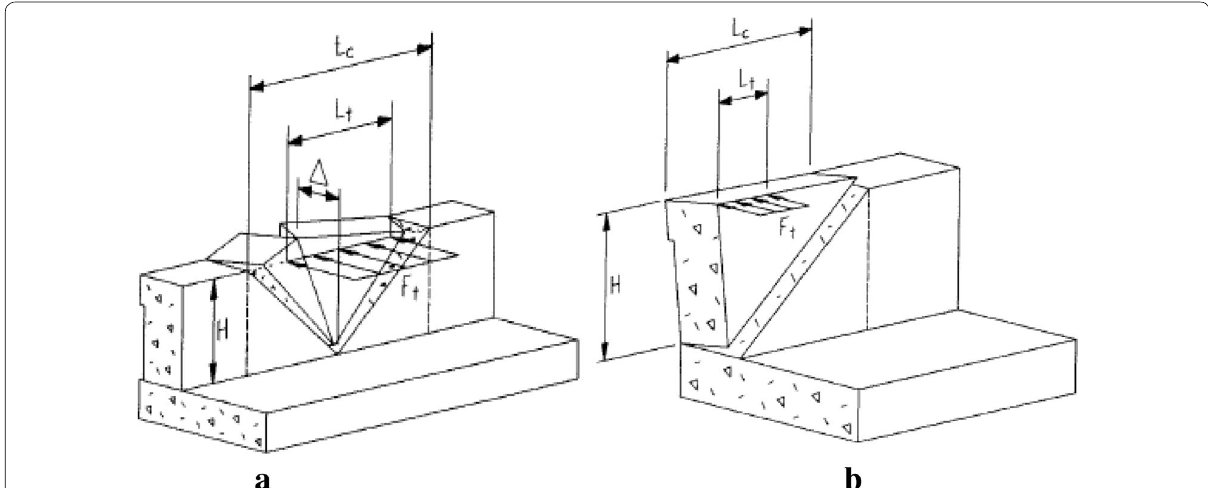
Fig. 1 LRFD yield-line analysis of barrier wall (redrawn from AASHTO 2012). a Interior region, b end